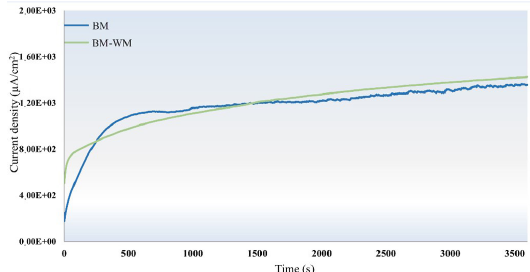
Figure 9. Current density comparative curves as a function of time during the potentiostatic step (PS) in the crevice corrosion test in BM and BM-WM in NaCl 3.5% solution (20 ± 2 °C).